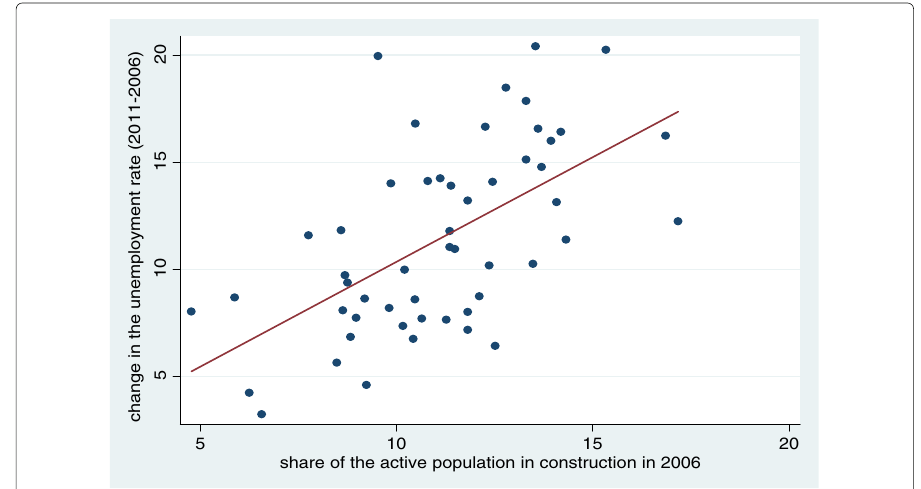
Fig. 3 Changes in unemployment and the construction sector. Note: Each point represents one of the 52 Spanish provinces. Source: Spanish Labor Force Survey